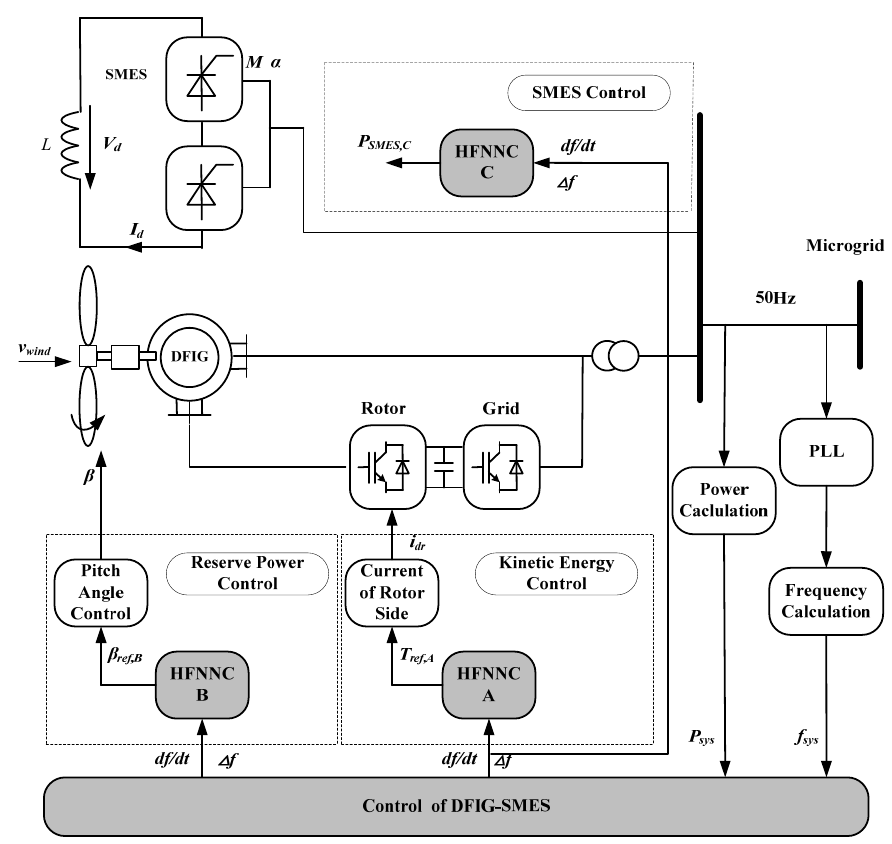
Figure 5. Frequency control of